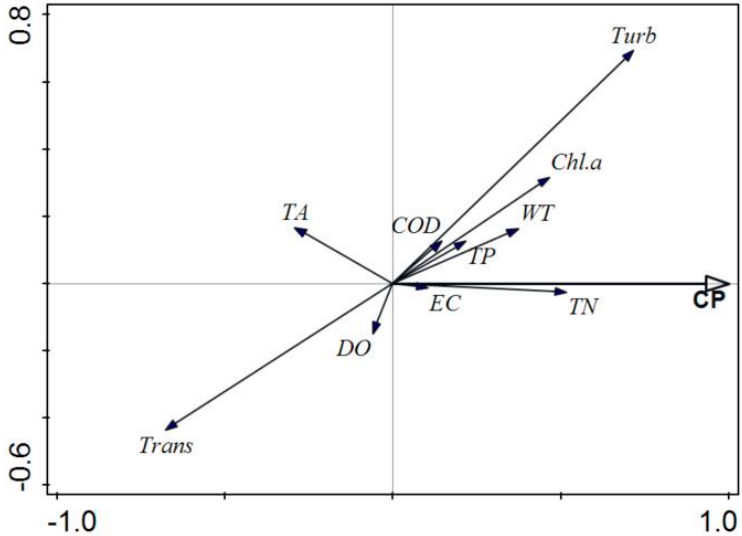
Figure 8. RDA ordination biplot of water environment variables and meteo-hydrological factors in the upstream inflow area of LR, China.